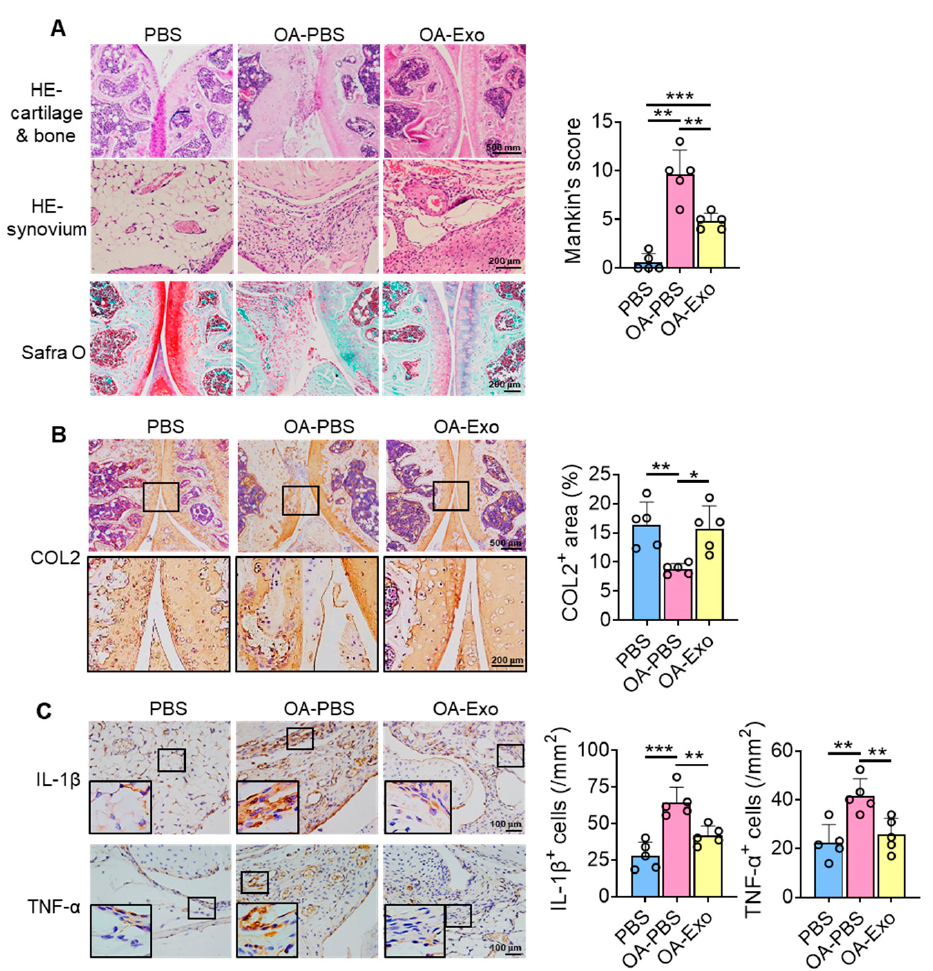
Figure 3. DPSC-Exos local injection improved cartilage degradation and synovial inflammation in progressive knee OA. ( A ) Representative images of HE and Safranin-O staining of the mice knee. The results of Mankin scoring system showed significant difference between OA-PBS and OA-Exo groups. ( B ) Representative images and semi-quantitative analysis of collagen II (COL2) in femoral and tibial cartilage by IHC staining. ( C ) Representative images and semi-quantitative analysis of IL-1 β and TNF- α in synovium by IHC staining. The data of semi-quantitative analysis were presented by mean ± SD. * p < 0.05, ** p < 0.01, *** p < 0.001; n = 5.